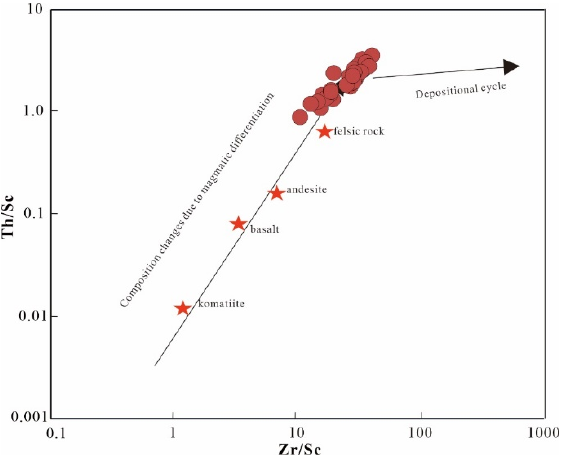
Figure 7. Th/Sc-Zr/Sc diagram of sandstone of the Sifangtai Formation in northwest Songliao Basin (after McLennan et al. [22]).